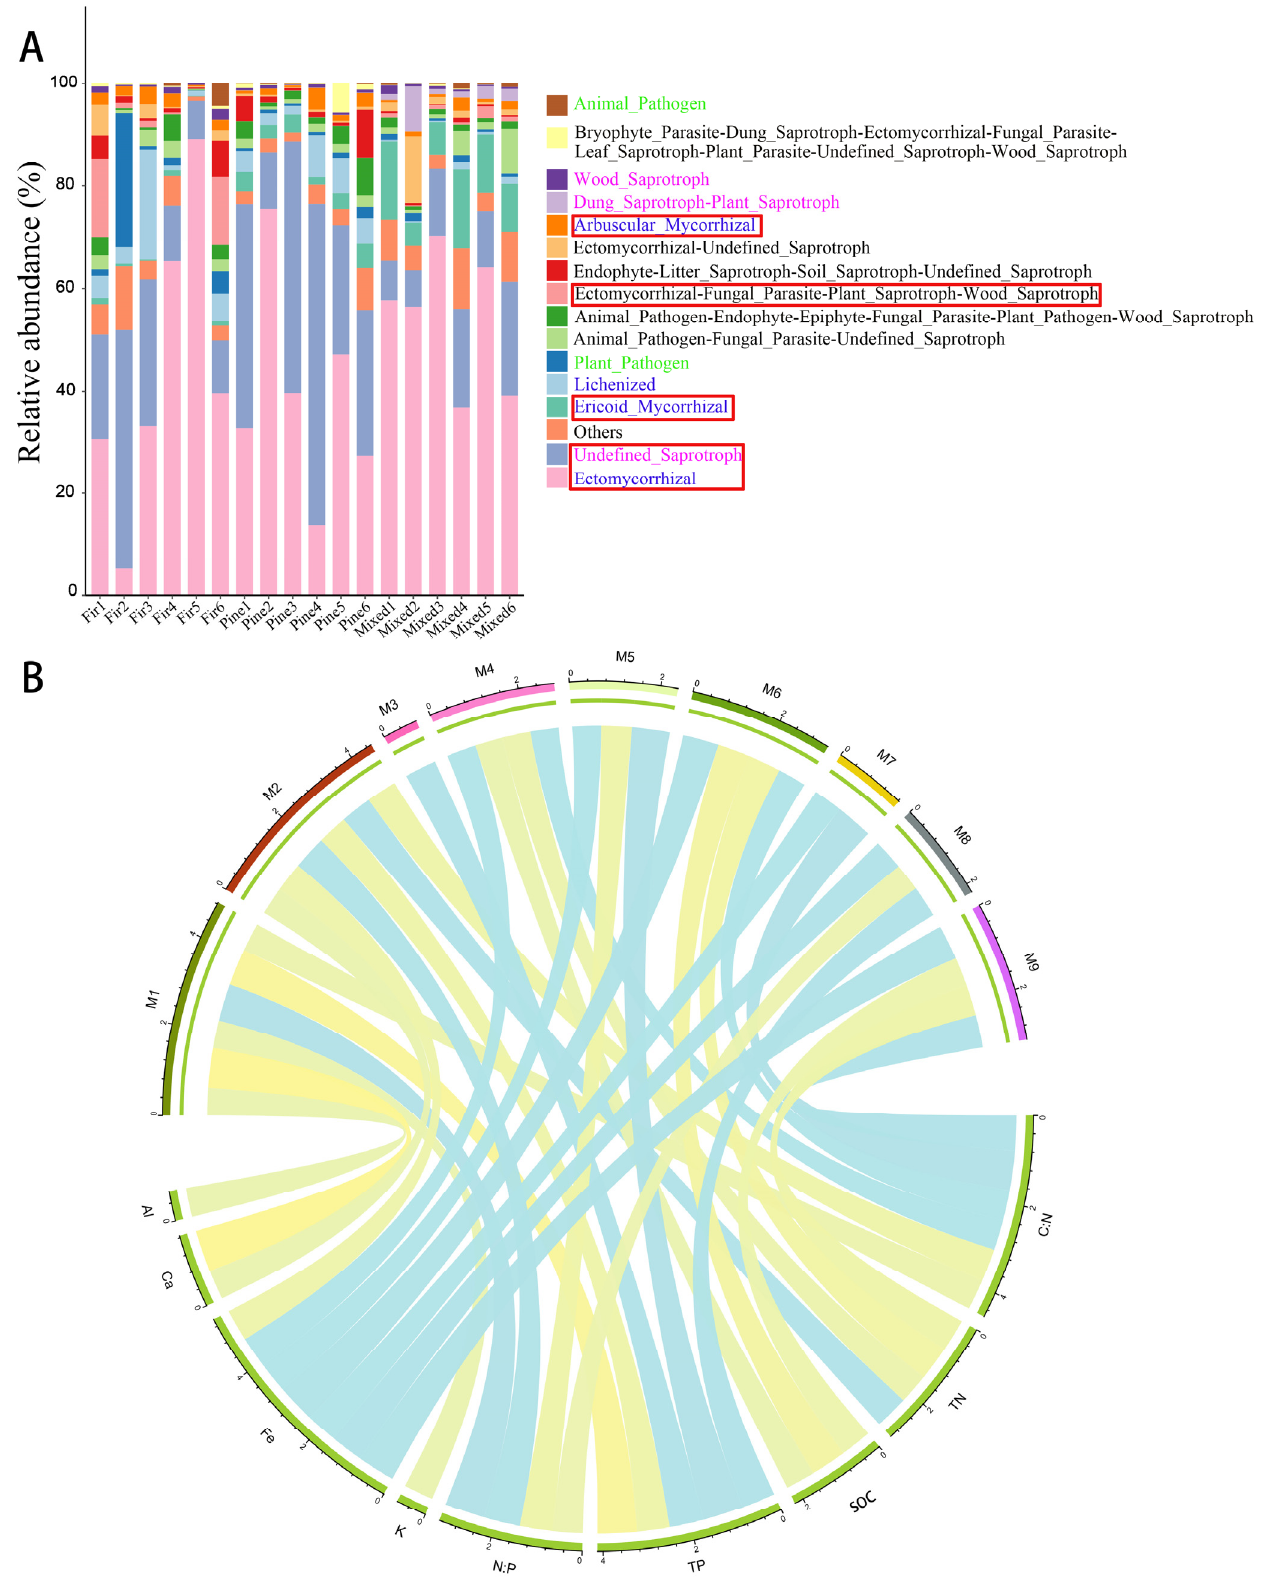
Figure 4. Fungal functional guilds and their correlation with soil chemistry. ( A ) The relative read abundance of annotated fungal functional guilds in pure and mixed forest. The guilds with a relative read abundance of <1% were combined and grouped as others; letters in blue are symbiotrophs, purple are saprotrophs, green are pathotrophs, black are complex nutrient types and the red